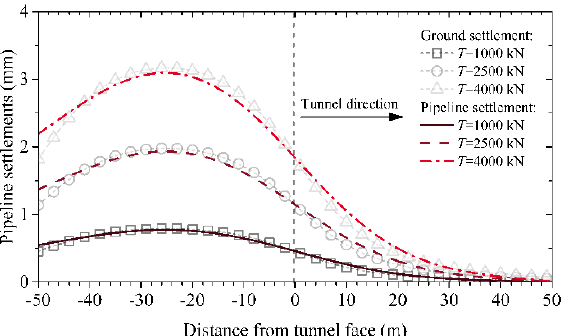
Figure 15. Longitudinal profiles of pipeline’s deformation with different torsional forces.